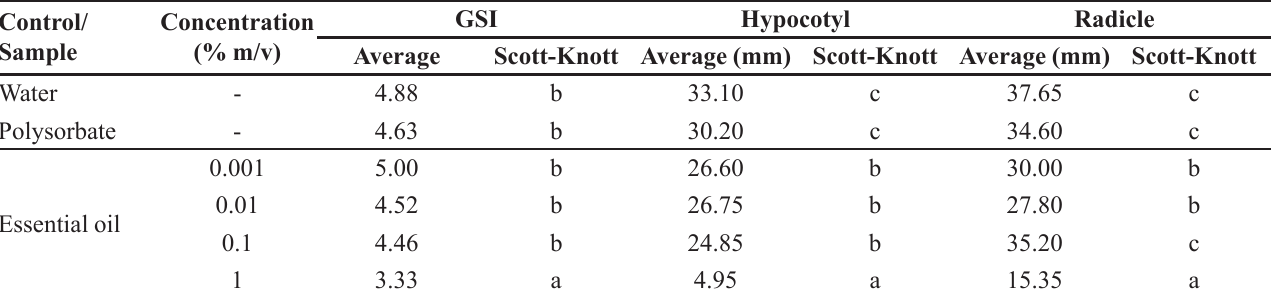
TABLE IV - Influence of essential oil of Myrcia hatschbachii on GSI and growth of hypocotyls and radicles of Lactuca sativa